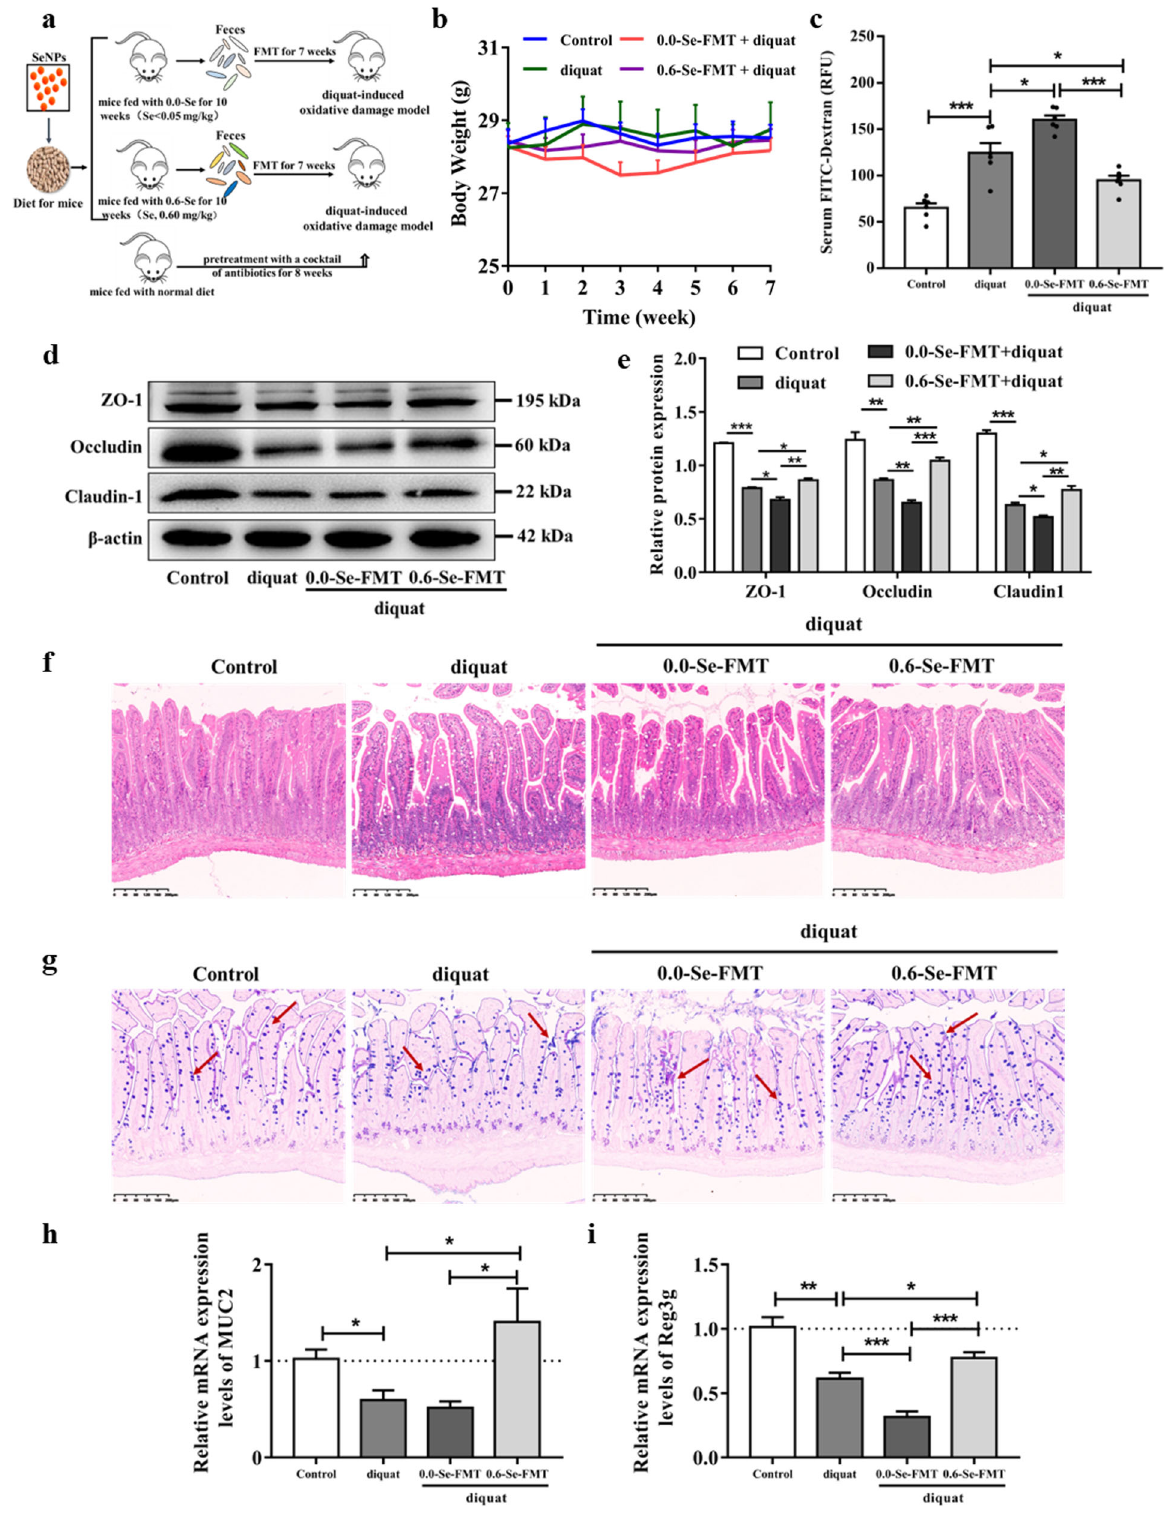
Fig. 7 Effects of FMT on the intestinal barrier in mice exposed to diquat. a Schematic diagram of the FMT experiment. b Body weight during FMT. c FITC-dextran levels in the serum of mice. ( n = 6). d , e The expression levels of tight junction proteins (ZO-1, occludin, claudin1) were measured by Western blot analysis ( n = 3). f Jejunum morphology was observed by H&E staining ( n = 4). g Goblet cells in the jejunum were observed by AB-PAS staining. h mRNA expression level of MUC2 in the jejunum ( n = 6). i mRNA expression level of REG3G in the jejunum ( n = 6). Data are expressed as the fold change versus the 0.3-Se group or the 0.3-Se + diquat group (set to 1). Data are represented as mean ± SEM. * P < 0.05; ** P < 0.01; *** P <